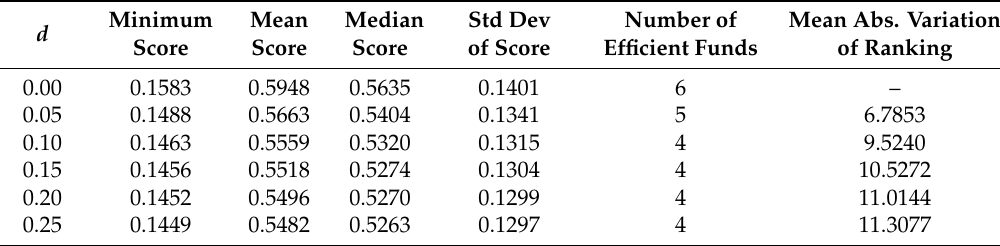
Table 9. Main results for the VW restrictions with constraints only on the target DMU in the case of asymmetric bounds and T = 7. Summary statistics on the performance scores (minimum, mean and median values, standard deviation), number of efficient funds and mean absolute variation (divided by 2) of the ranking positions.